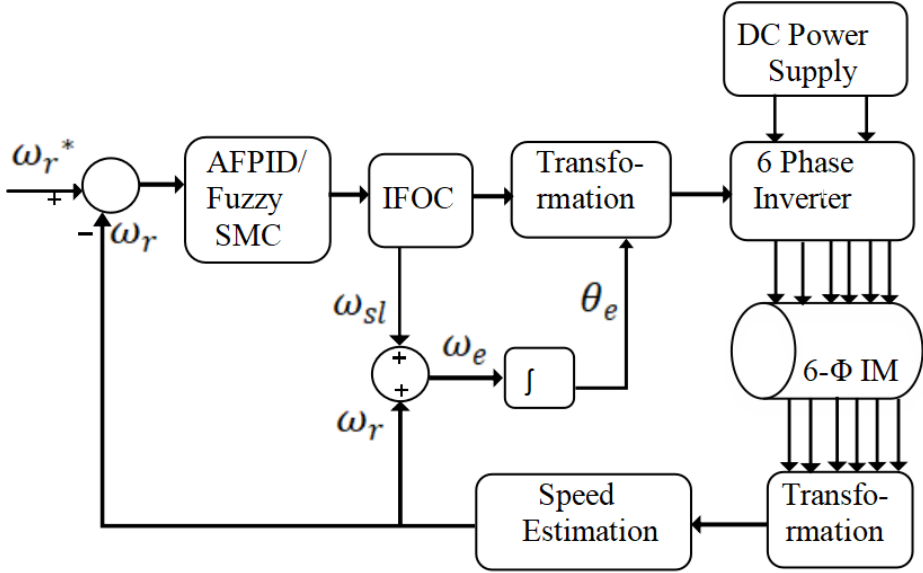
Figure 2. A block diagram of sensorless speed control for six-phase induction